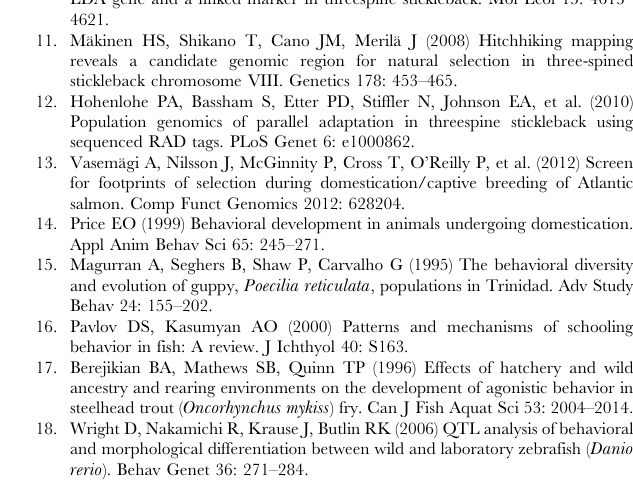
and morphological differentiation between wild and laboratory zebrafish ( Danio rerio ). Behav Genet 36: